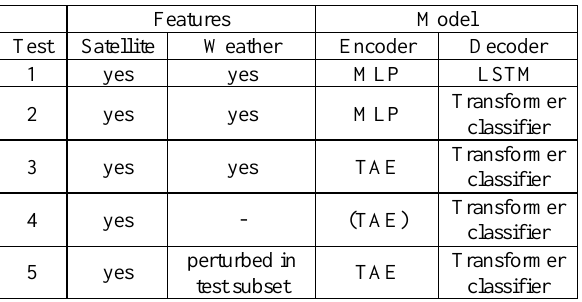
Table 2. Summary of the experiments presented.